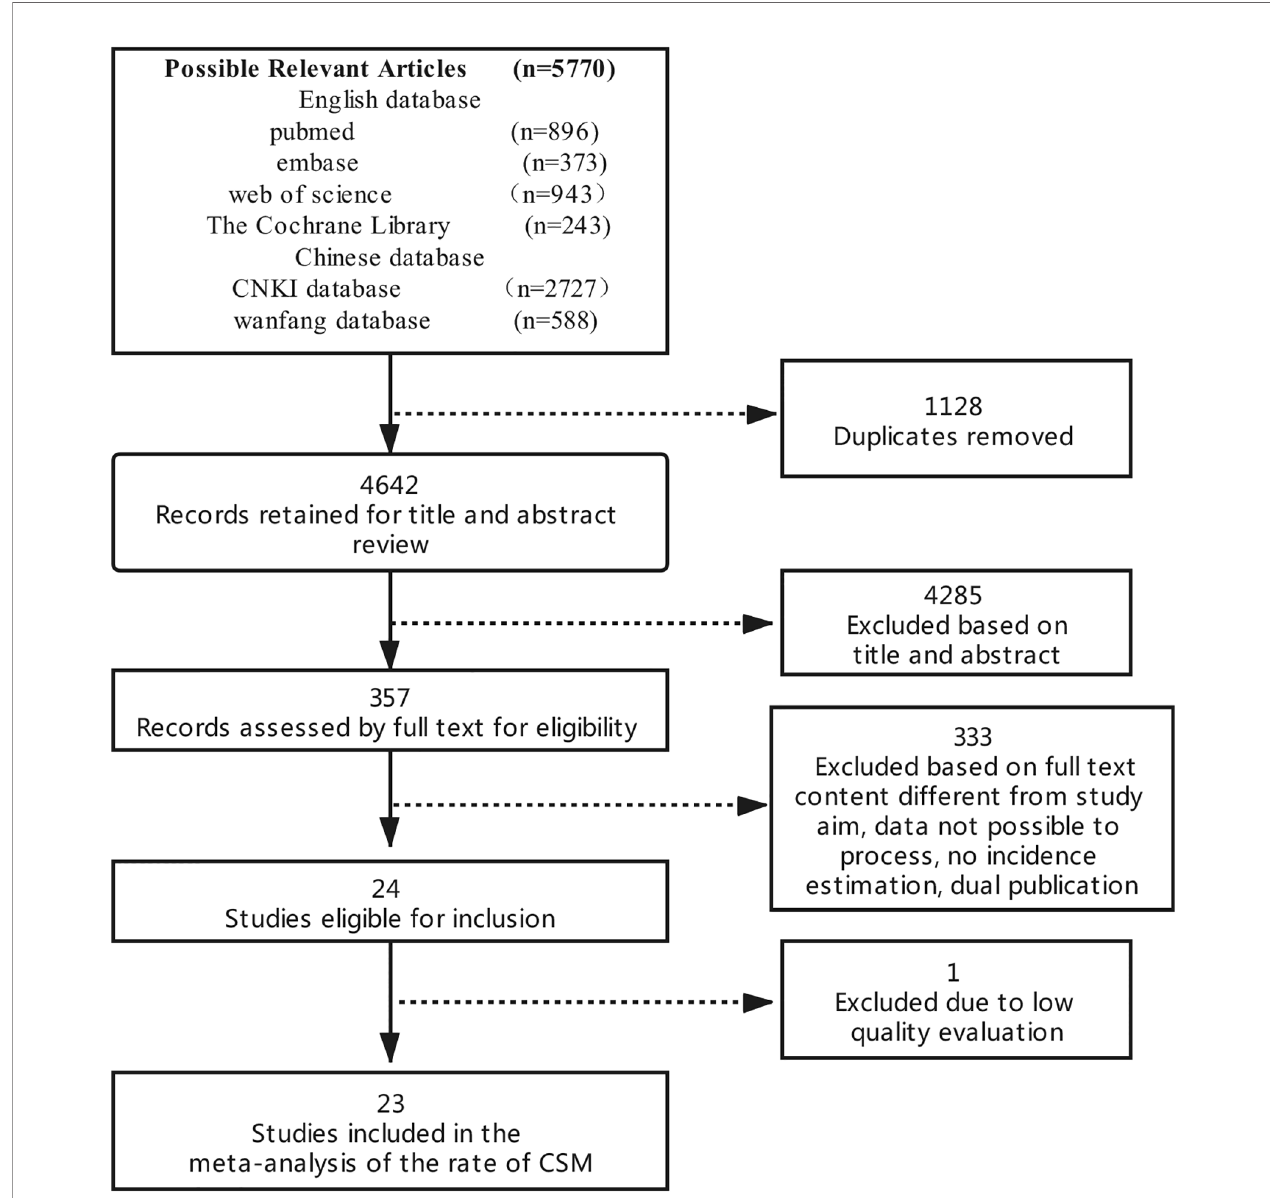
FIGURE 1 | Flow chart of literature screening. CSM, concentric shrinkage